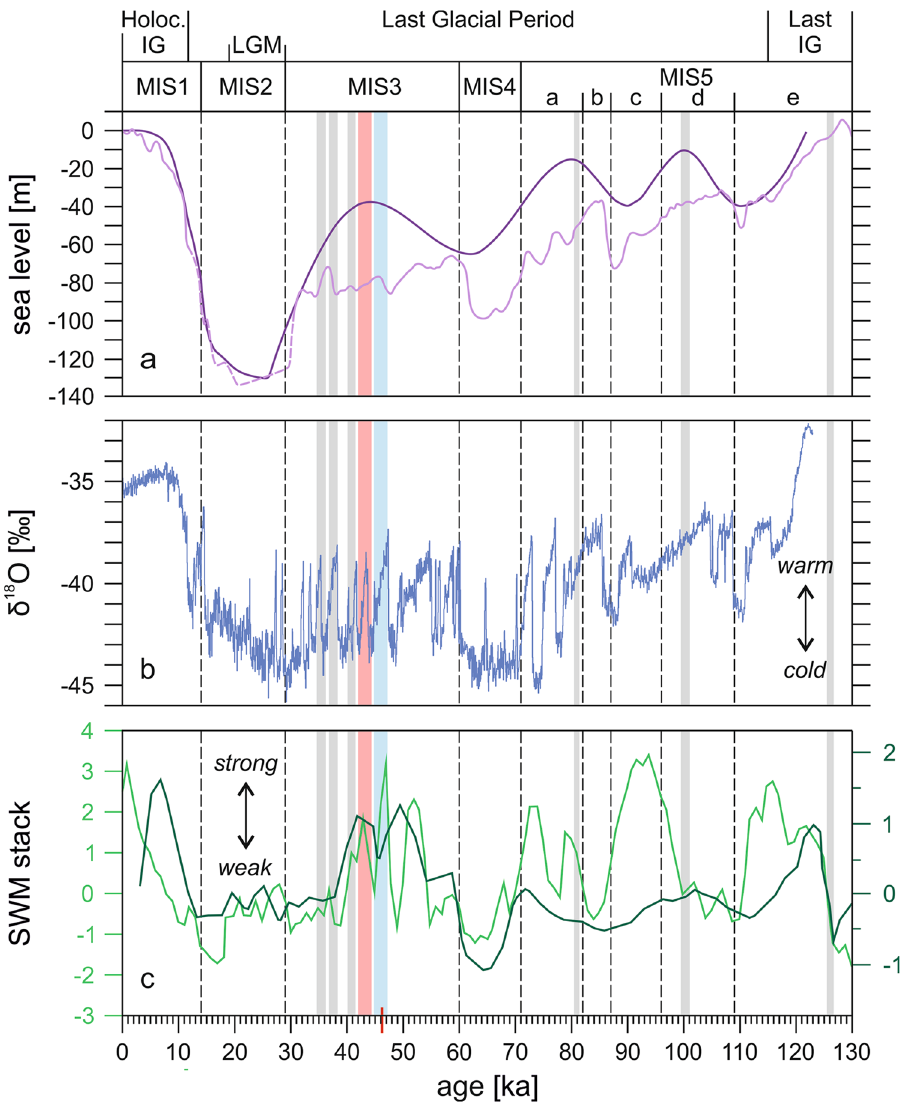
Figure 4. Stratigraphic distribution and climate relationships of late Quaternary Tridacna records in the Gulf of Oman and Persian Gulf (vertical bars: blue = T-Tiwi1, red = T-Fins). The red mark on the time axis denotes the maximum age limit of the dating technique applied herein. IG interglacial, LGM last glacial maximum, MIS marine isotope stage. ( a ) Sea-level changes [light purple: global relative sea level (solid line 25 , dashed line 26 ), dark purple: global mean sea-level change predicted from ice history simulations 23 ]. ( b ) Dansgaard-Oeschger temperature fluctuations as recorded in the North Greenland ice cores 37 . ( c ) SWM multi-proxy stacks from the northern Arabian Sea (dark green: Owen Ridge 48 , light green: Little Murray Ridge 49 ; Fig. 1b). The double head arrow indicates SWM